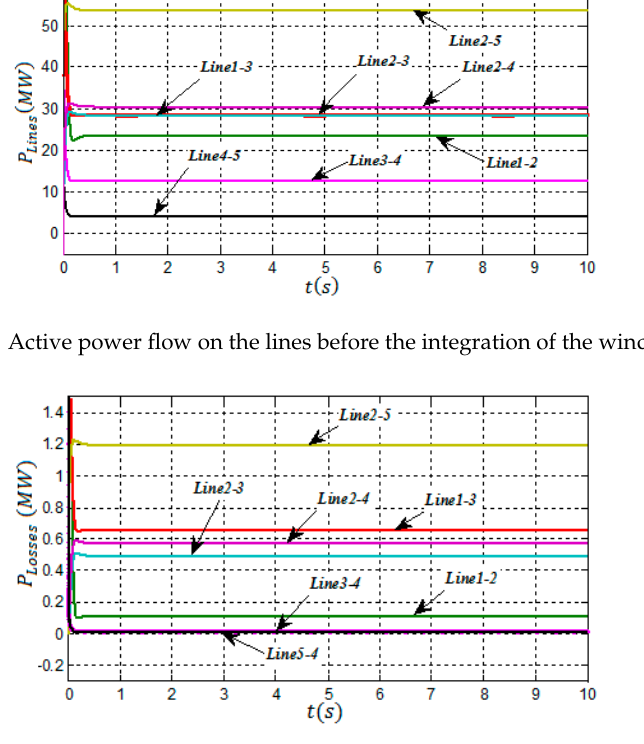
Figure 12. Active power flow on the lines with the wind farm connected at bus 5. Figure 13. Active power losses in the lines with the wind farm connected at bus 5.